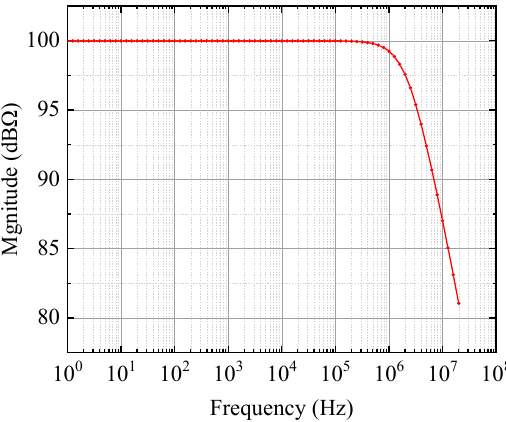
Figure 6. Simulation result of the amplifier’s frequency response.